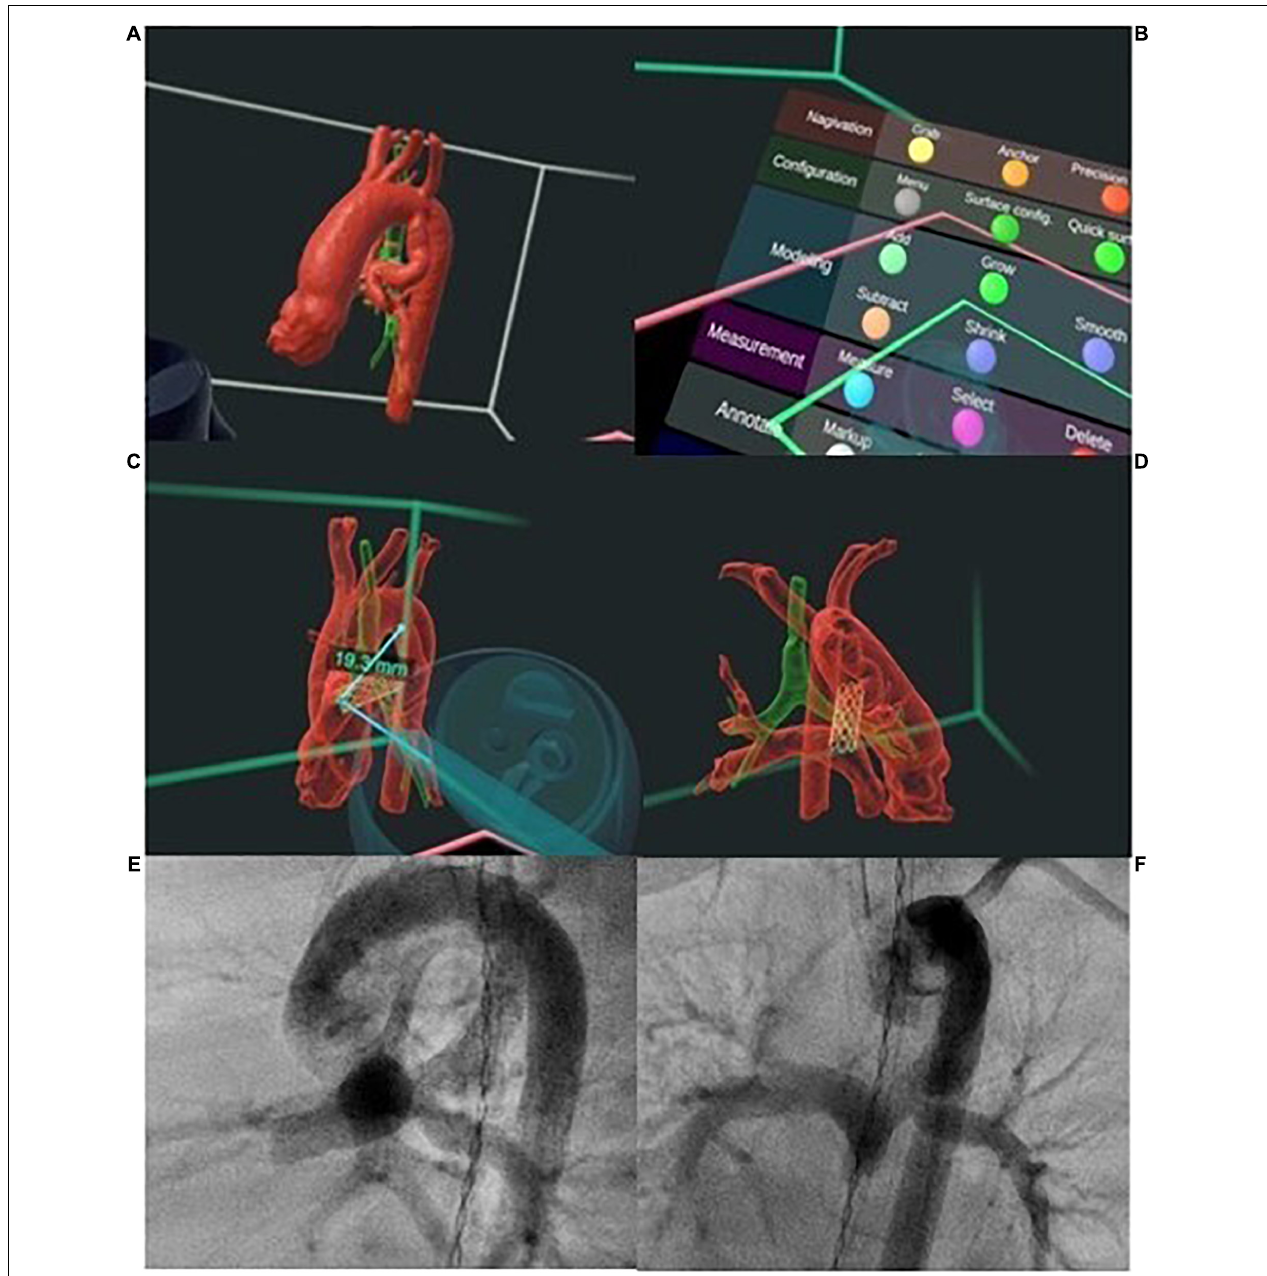
FIGURE 7 | Digital-reality technologies enable true three-dimensional (3D) modeling and simulation prior to patent ductus arteriosus (PDA) stenting. (A) The 3D model of the PDA in relation to the airway, can be interrogated (B) using a range of interactive features including (C) measurement of distances in 3D space and (C,D) overlaying of stent in the PDA. (E,F) Visualization of the morphology of the 3D model in unlimited planes allows selection of optimal angiographic projection for intervention and planning of the number of stents and length of stent to cover the entire PDA. Post procedure angiography showing position of PDA stent as planned with unobstructed flow into branch pulmonary